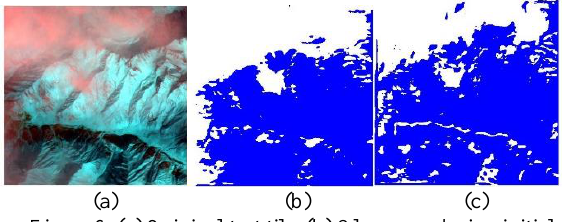
Figure 6. (a) Original test tile, (b) Class map during initial stages of testing and (c) Class map during later stages of testing; blue represents snow while white represents